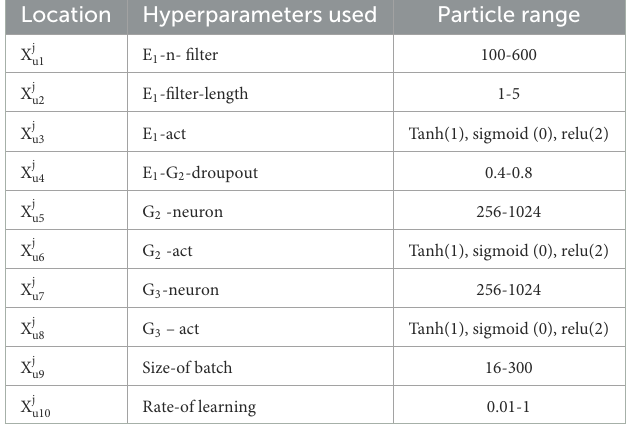
TABLE 2 Position Parameters range of value.